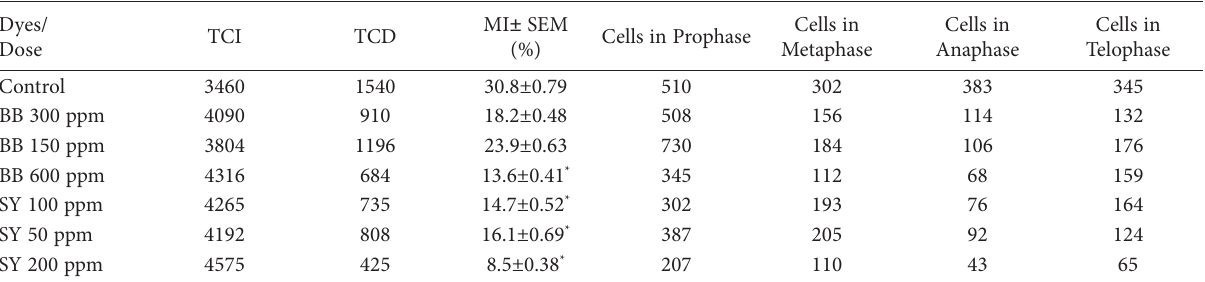
Table 1. Total number of analysed cells and Mitotic index (%) in root tips of Allium cepa treated with different concentrations of Brilliant Blue and Sunset Yellow food